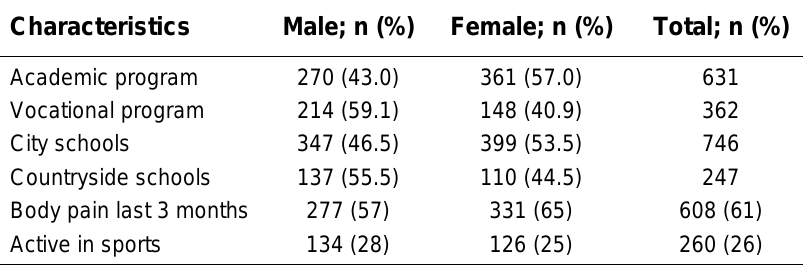
Main Characteristics of the Subjects (n =